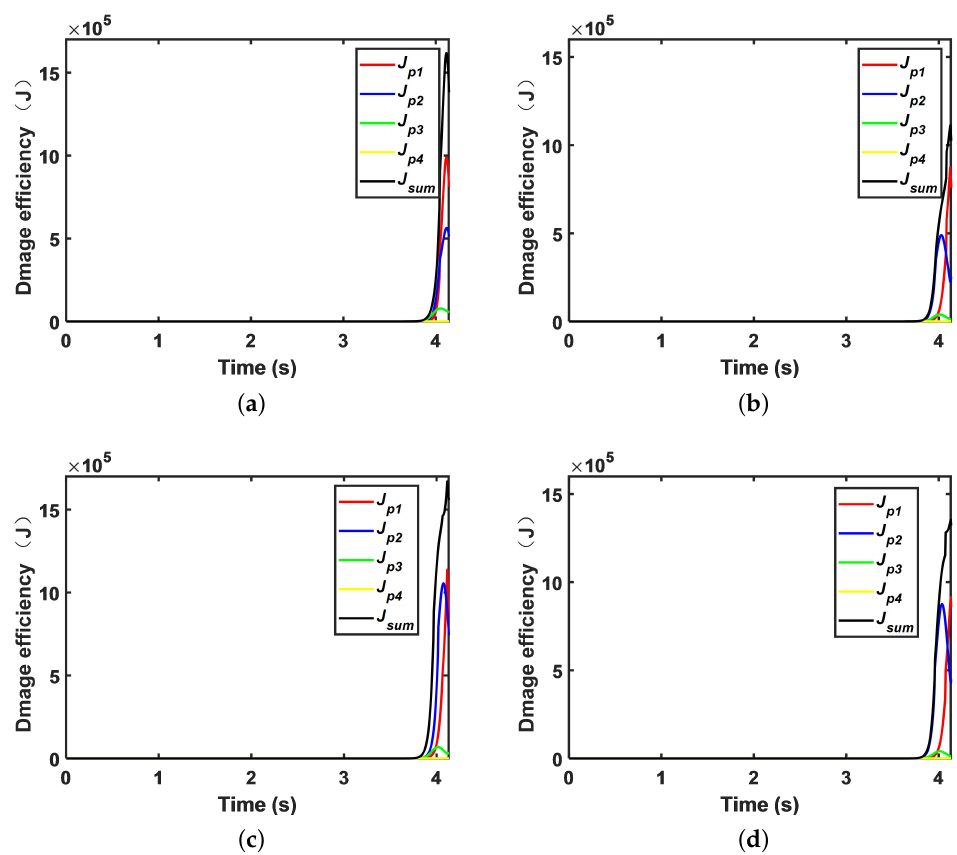
Figure 8. Unit fragment damage efficiency: ( a ) proposed strategy; ( b ) strategy from the literature [13];